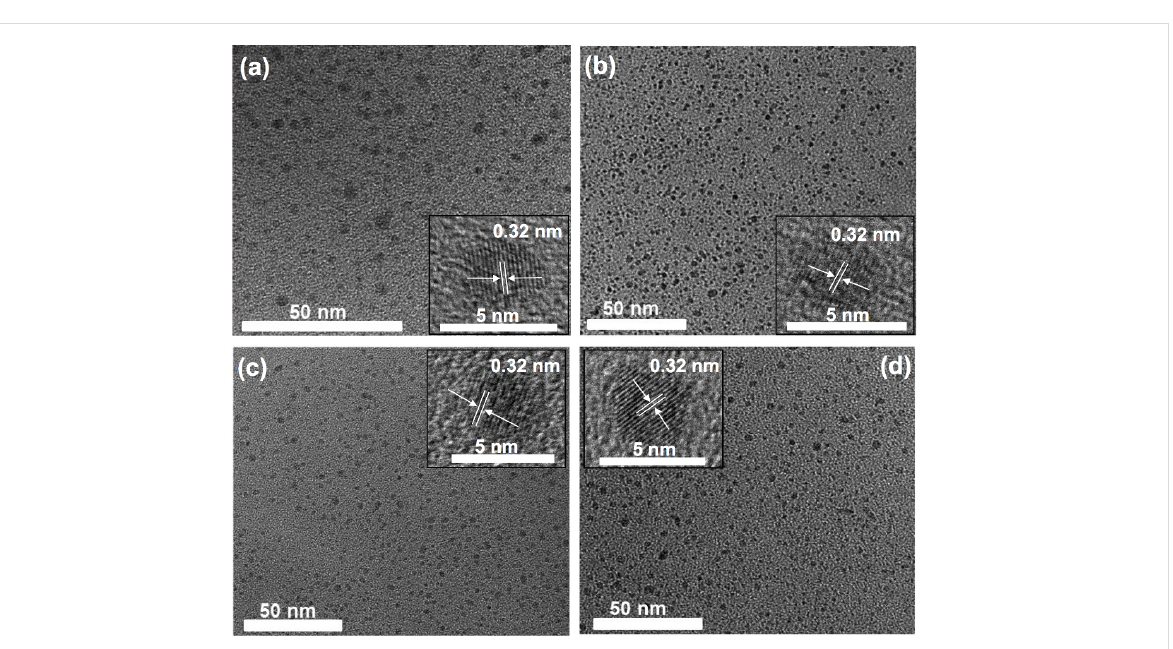
Figure 3: TEM images of (a) cinnamon, (b) red chilli, (c) turmeric and (d) black pepper C-dots. Insets: the crystalline lattices are identified in each cor- responding C-dots, and have been estimated as the distance between two parallel dark lines observed in the TEM images.